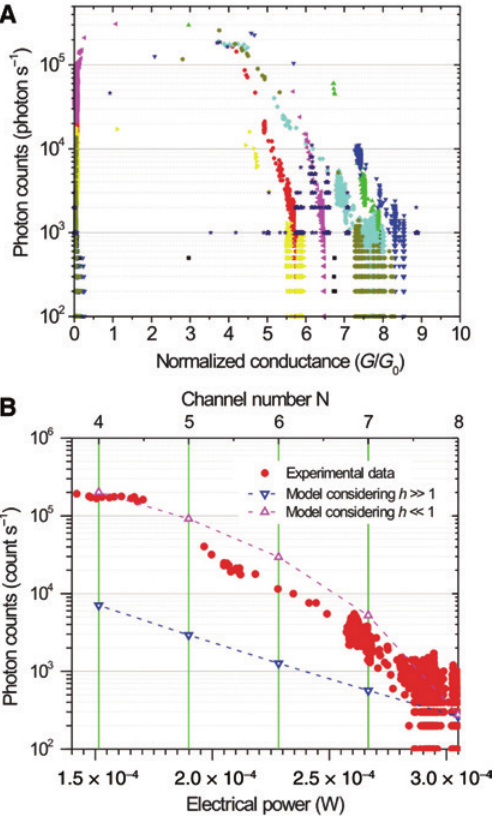
Figure 3: Photo counts versus conductance and electrical